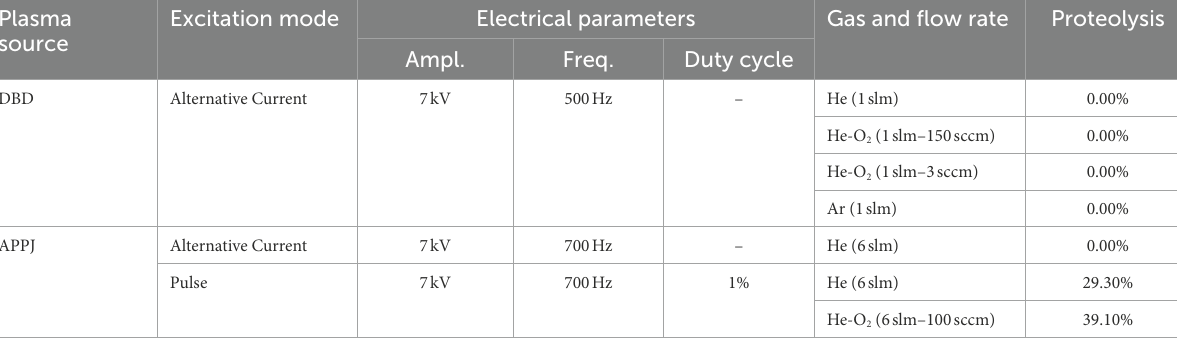
TABLE 1 Experimental parameters of cold plasma sources used to remove surface-bound